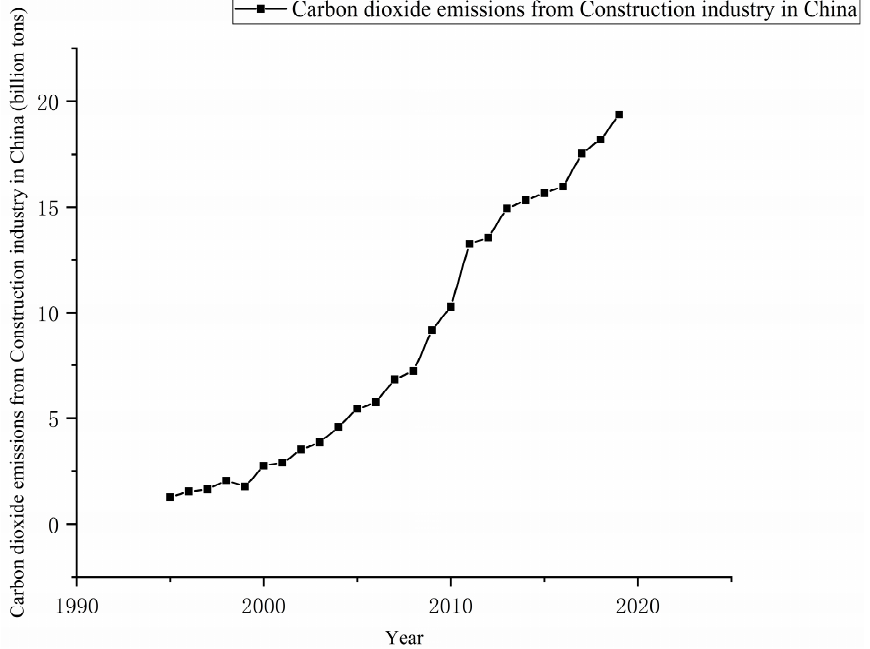
Figure 4. Carbon emissions of China’s construction industry (billion tons).